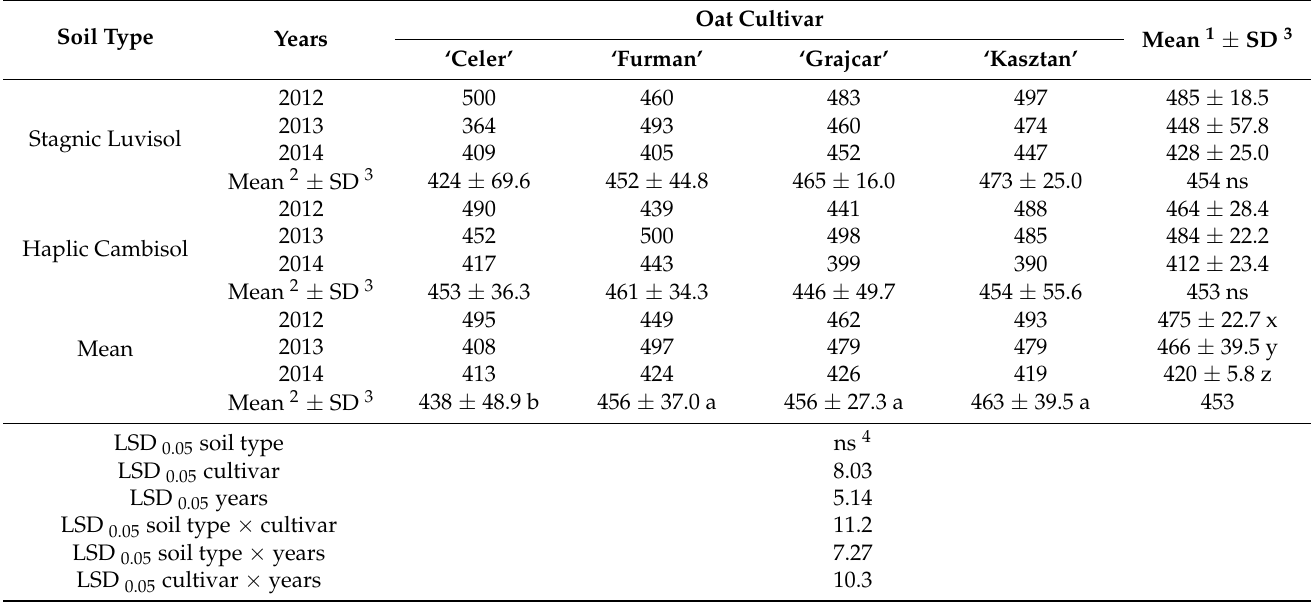
Table 4. Oats’ density in spring (pieces m − 2 ) in mixture depending on the soil type (factor I), oat cultivar (factor II), and study years (factor III).